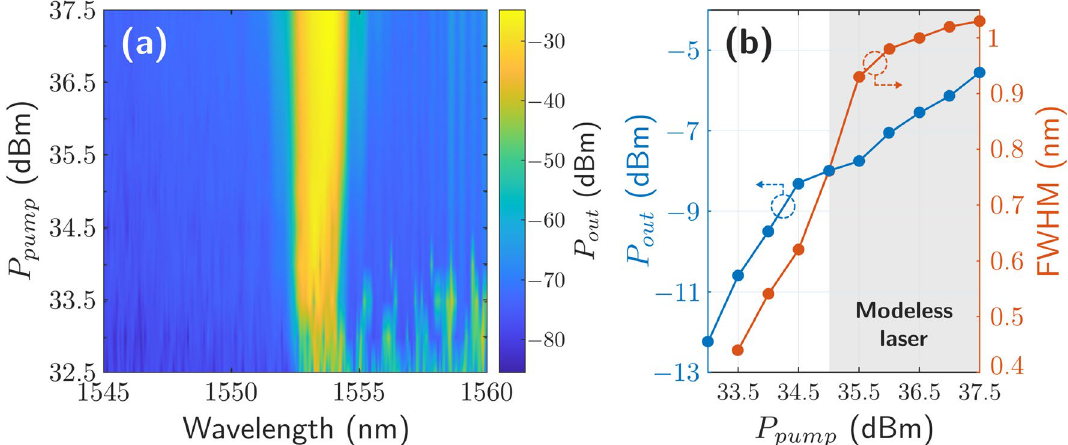
Figure 4. ( a ) Relationship between the pump power and output power levels as a function of wavelength (MATLAB R2020b, contourf command. https:// es. mathw orks. com/ produ cts/ matlab. html). ( b ) Relationship between the output power and FHWM values as a function of pump